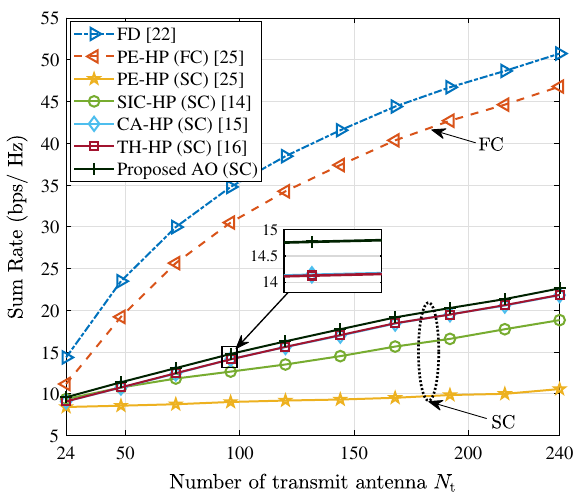
Fig. 3 Sum rate versus number of transmit antennas ( N t ). We set K = M = 12 and SNR = 0 dB